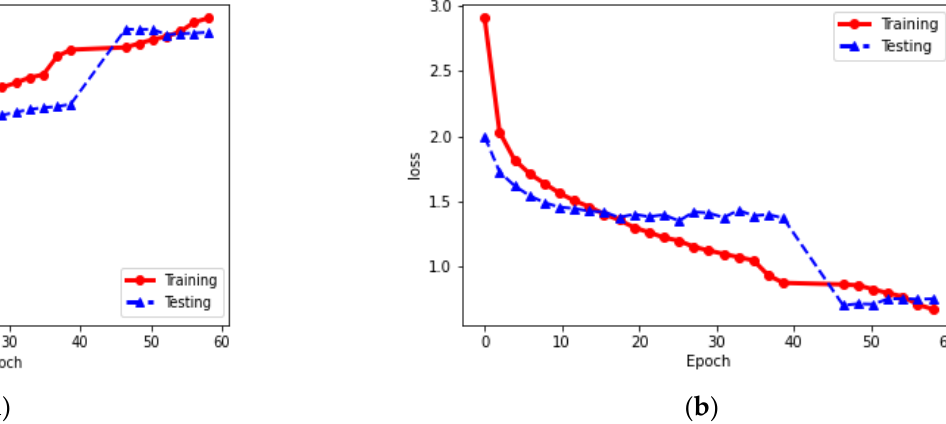
Figure 4. Performance accuracy and loss curves over epoch on the Blogs50 datasets: ( a ) accuracy, ( b ) loss.